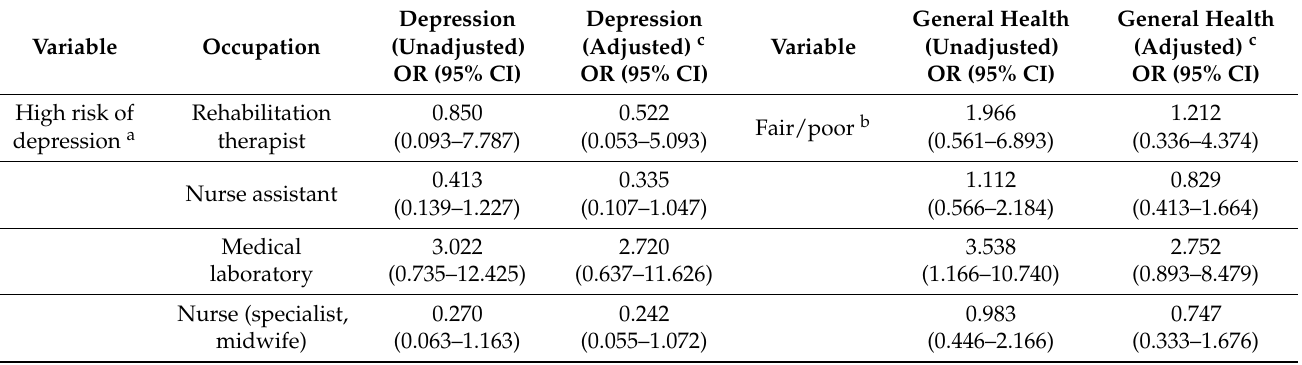
Table 5. Associations between health consequences (general health and depression) and occupation in health-care workers involved weekly or daily in COVID-19 care (N =